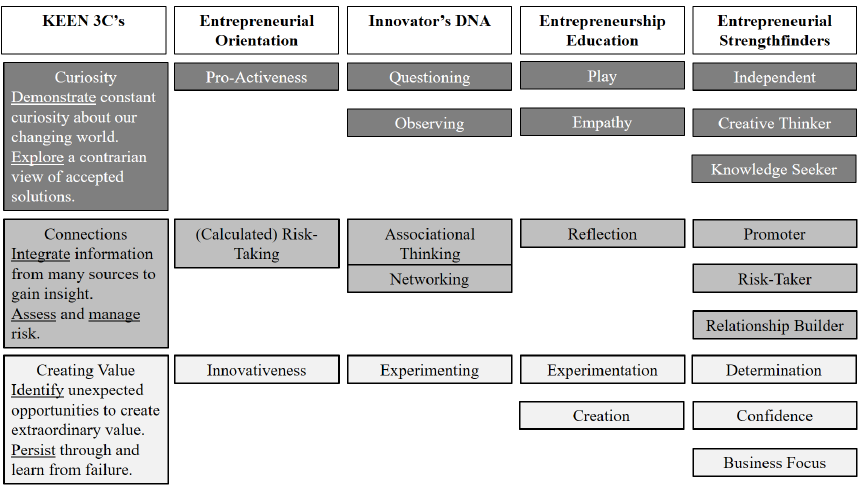
Fig. 1. Summary of Entrepreneurially-Minded